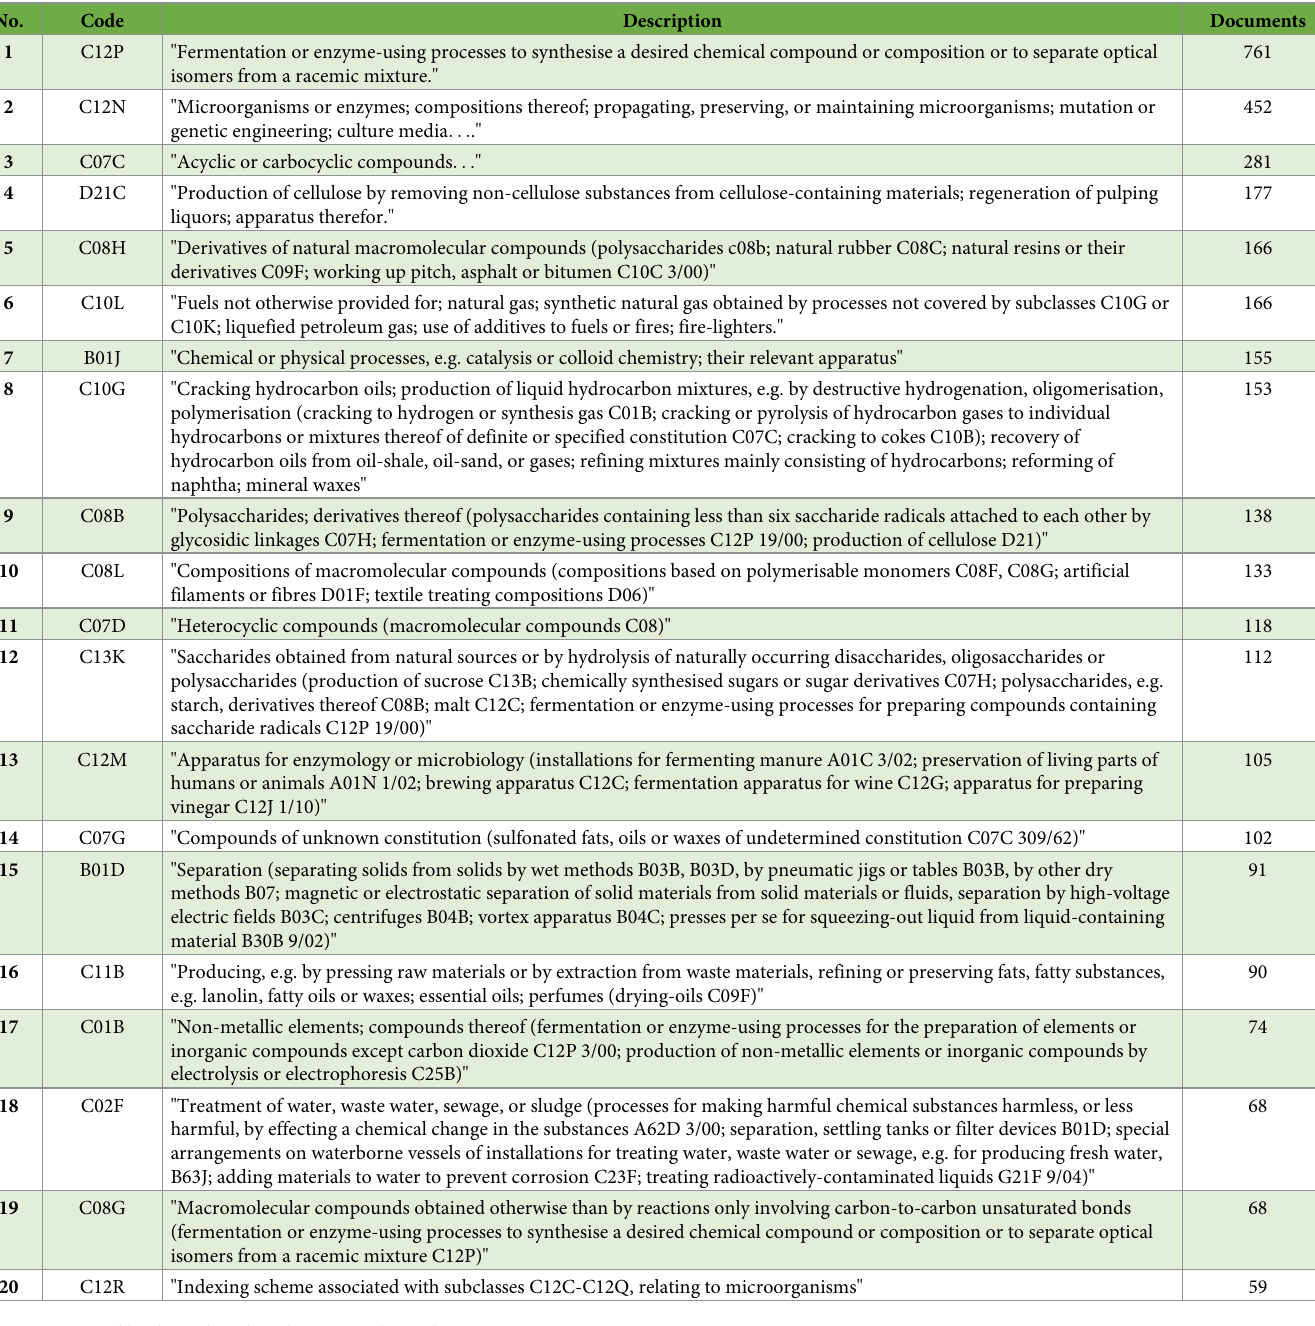
Table 1. Main technological sectors, International Patent Classification